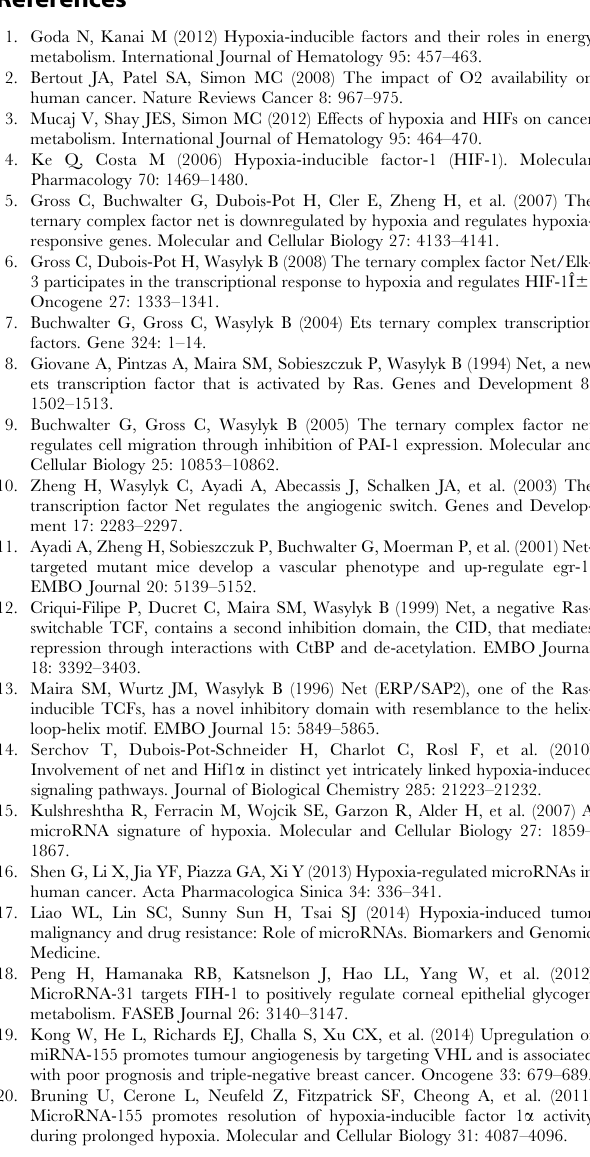
Figure S2 ELK3 mRNA degradation in anoxia (0% oxygen) in SEND cells. (A) Northern blot of total RNA extracted from SEND cells cultured in 0% oxygen for the designated times and probed for ELK3 and RPLPO. The locations of 18S and 28S ribosomal RNA are indicated. (B) Northern Blot quantification. The major Elk3 band (3, 1,600 bases) was quantified by scanning suitably exposed autoradio- grams, correcting for RPLPO, and normalizing to the zero time point. One representative example of four independent experi- ments is shown. (C) HIF1 a induction under 0% oxygen conditions. HUVEC cells were incubated in 0% oxygen for the indicated times and whole cell extracts were analysed by western blotting with antibodies against HIF1 a and TBP as a loading control. (D) VEGF mRNA induction under 0% oxygen condi- tions. HUVEC cells were incubated in 0% oxygen for the indicated times, and extracted RNA was analysed by RT-QPCR for VEGF and RPLPO RNA levels. VEGF RNA levels were corrected for the internal control RPLPO, and normalized to the 0 h time point. (E) HUVEC cells viability during hypoxia in a